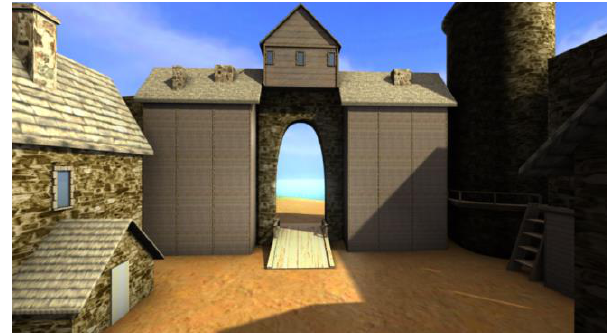
Figure 7. The restoration of the entrance of Fort Frontenac in 3D computer